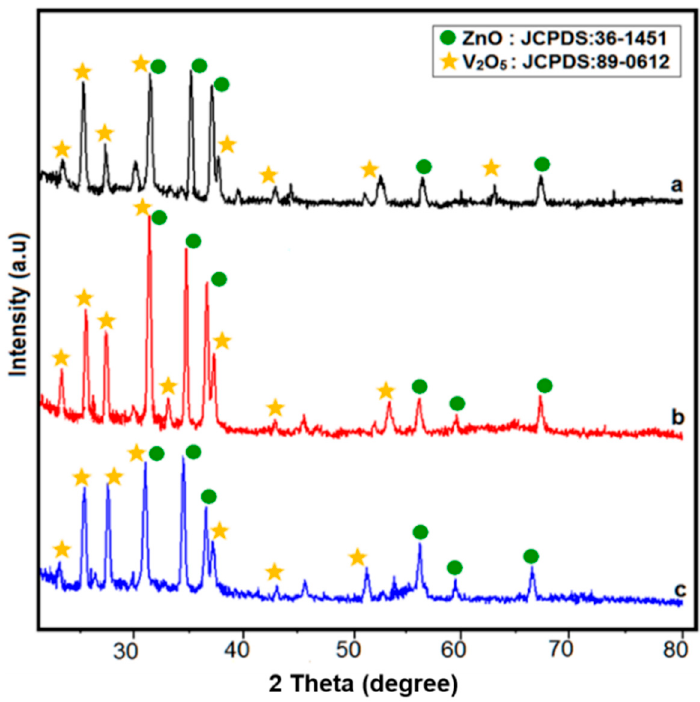
Figure 3. XRD patterns of ZnO/V 2 O 5 with seed layer deposition time of ( a ) 10 min, ( b ) 20 min, and ( c ) 30 min.